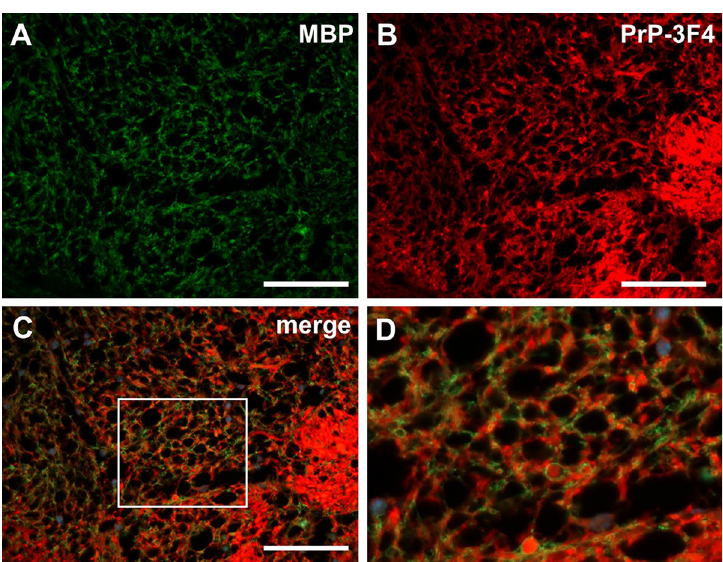
Fig 10. PrP-3F4 is localized either intra-axonally or within the myelin of axons in an anterior commissure damaged following inoculation of NBH. Widefield immunofluorescence microscopy of the anterior commissure 24 hrs after inoculation with NBH. Tissue was co-stained with antibodies to (A) MBP and (B) PrP-3F4. Dense, rounded staining consistent with intra-axonal PrP is visible in panel B. (C) Merged image of Panels A and B. (D) Close-up view of area enclosed by the box in (C) showing degenerated axons surrounded by both MBP and PrP-3F4 staining. Scale bar = 50 μ m.